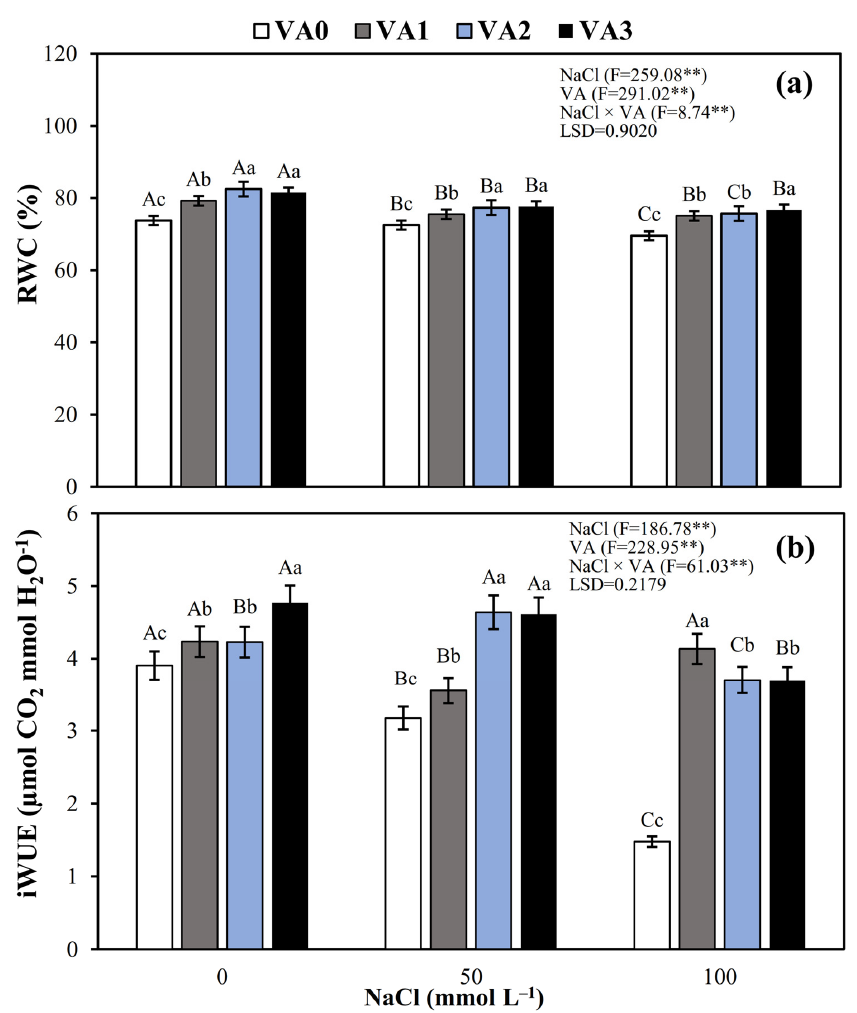
Figure 6. Relative water content (RWC) ( a ) and water-use efficiency (iWUE) ( b ) of soybean plants under different levels of salt stress and VA applications. Plants were submitted to four concentrations of VA (VA0, non-VA application; VA1, 0.4 mL L − 1 ; VA2, 0.8 mL L − 1 ; and VA3, 1.2 mL L − 1 ) under three levels of NaCl (0, 50, and 100 mmol L − 1 ). Data are mean ± SD (n = 5). Uppercase letters above bars indicate significant differences among NaCl concentrations at the same VA concentration. Lowercase letters above bars indicate differences among VA concentrations at the same NaCl concentration, according to LSD test ( p < 0.05). F values from ANOVA: ** p < 0.01.